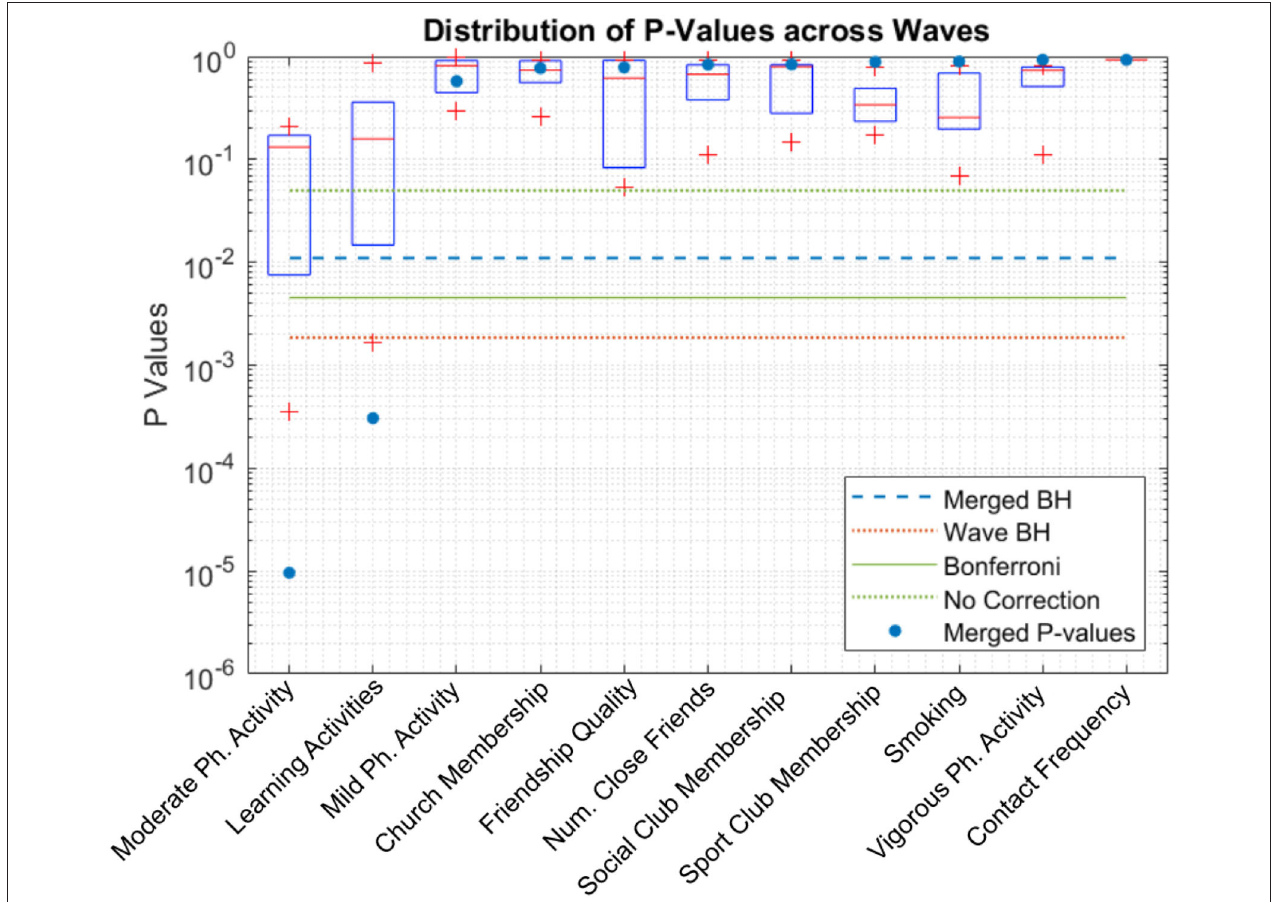
FIGURE 4 | Boxplot of p -values of each candidate. Learning activities and moderate-intensity physical activity pass the statistical test after p -value adjustment even for the more conservative adjustment method, Bonferroni. “Merged BH” and “Wave BH” indicate the significance thresholds for Benjamini-Hochberg method performed on p -values of merged waves and individual waves,